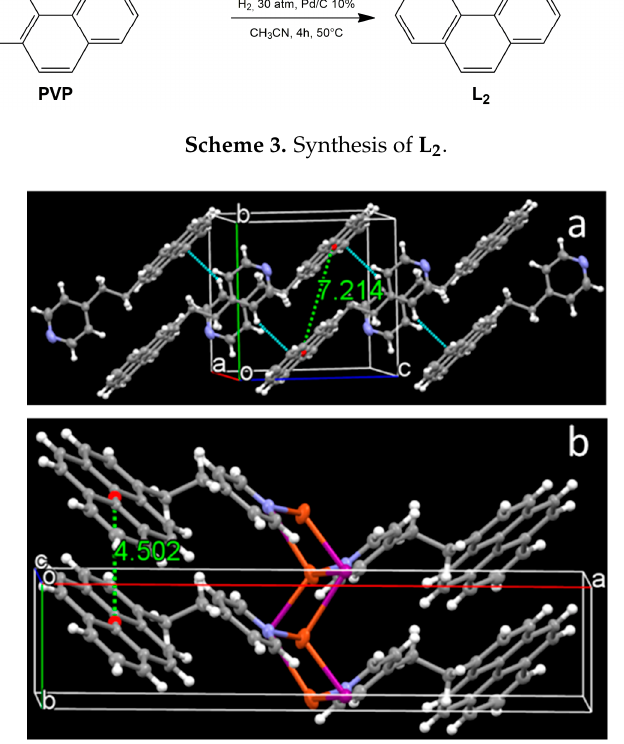
Figure 3. Fragments of the crystal packing of ( a ) L 2 (viewed approximately along the a direction) and ( b ) CuL 2 (viewed approximately along the c direction) showing C–H ∙∙∙π hydrogen bonds (light blue dashed lines) and distance between centroids of the pyrene units (green dashed line). Ellipsoids drawn at 30% probability.